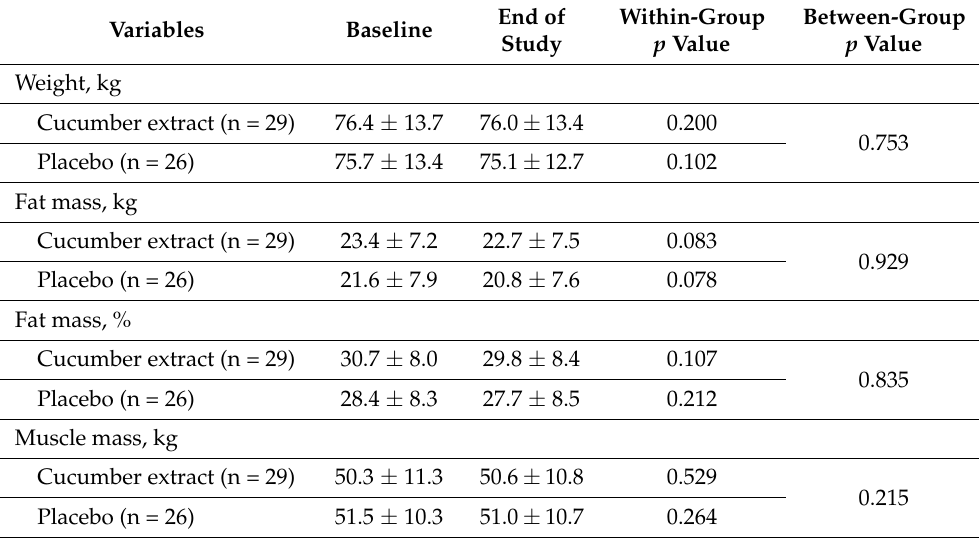
Table 6. Changes in body composition after supplementation with cucumber extract or placebo for 8 weeks.